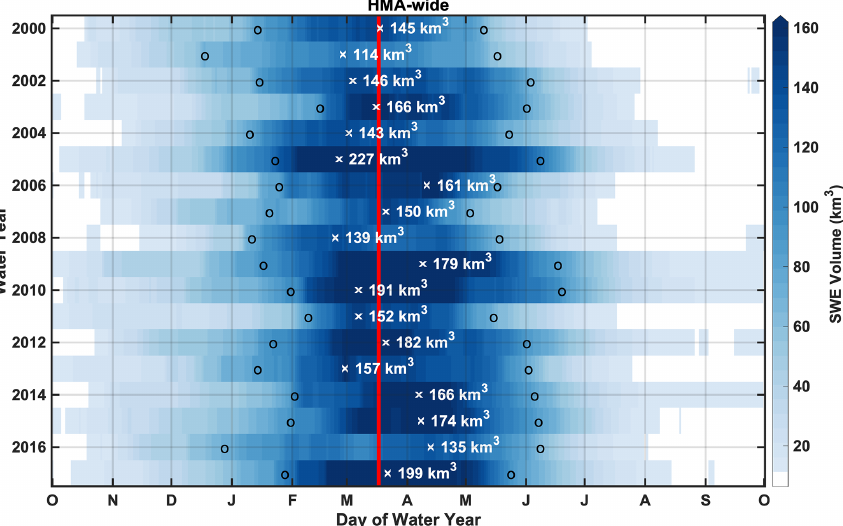
Figure 8. Daily time series of HMA-wide SWE volumes displayed as functions of DOWY and WY. The symbol “x” is used to mark the date of peak SWE volume occurrence, with the corresponding peak SWE volume labeled in each WY. The symbol “o” is used to mark the dates when 50% of the peak SWE volume is reached in each WY. The vertical red line is used to indicate the 18-year average timing of HMA-wide peak SWE volume.